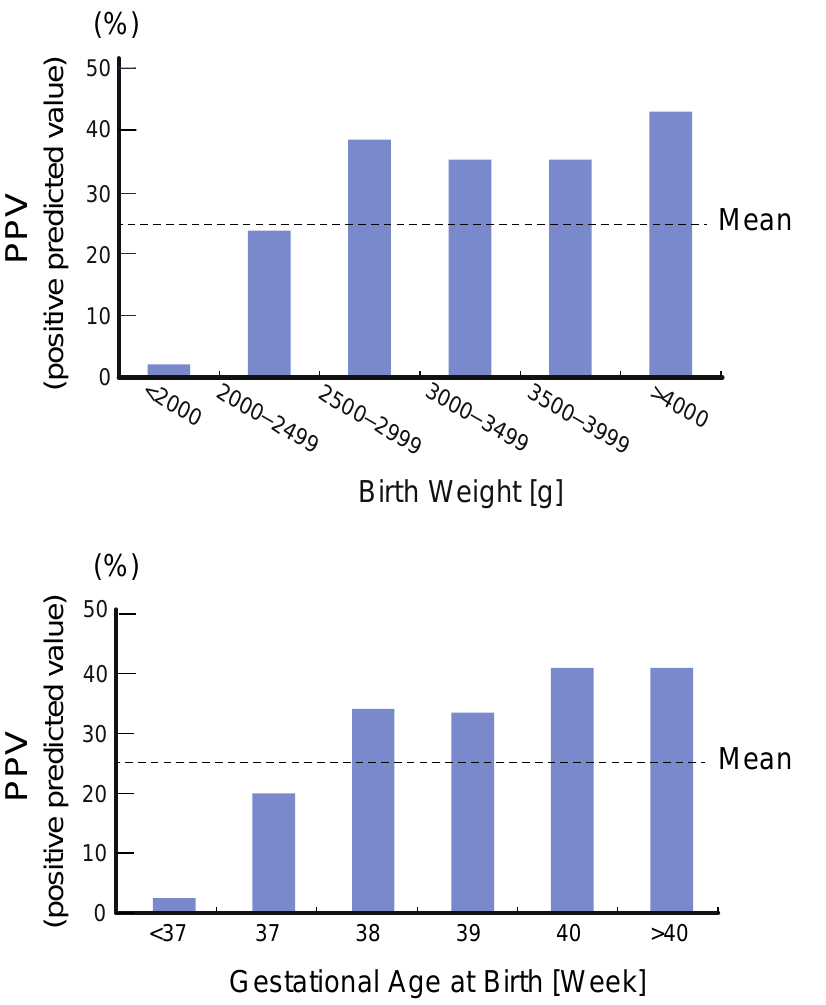
Figure 5. PPV (positive predicted value) of CAH screening in Tokyo according to the birth weights and the gestational ages of newborns judged as positive. (Modified from Tsuji et al., 2015 [5]).